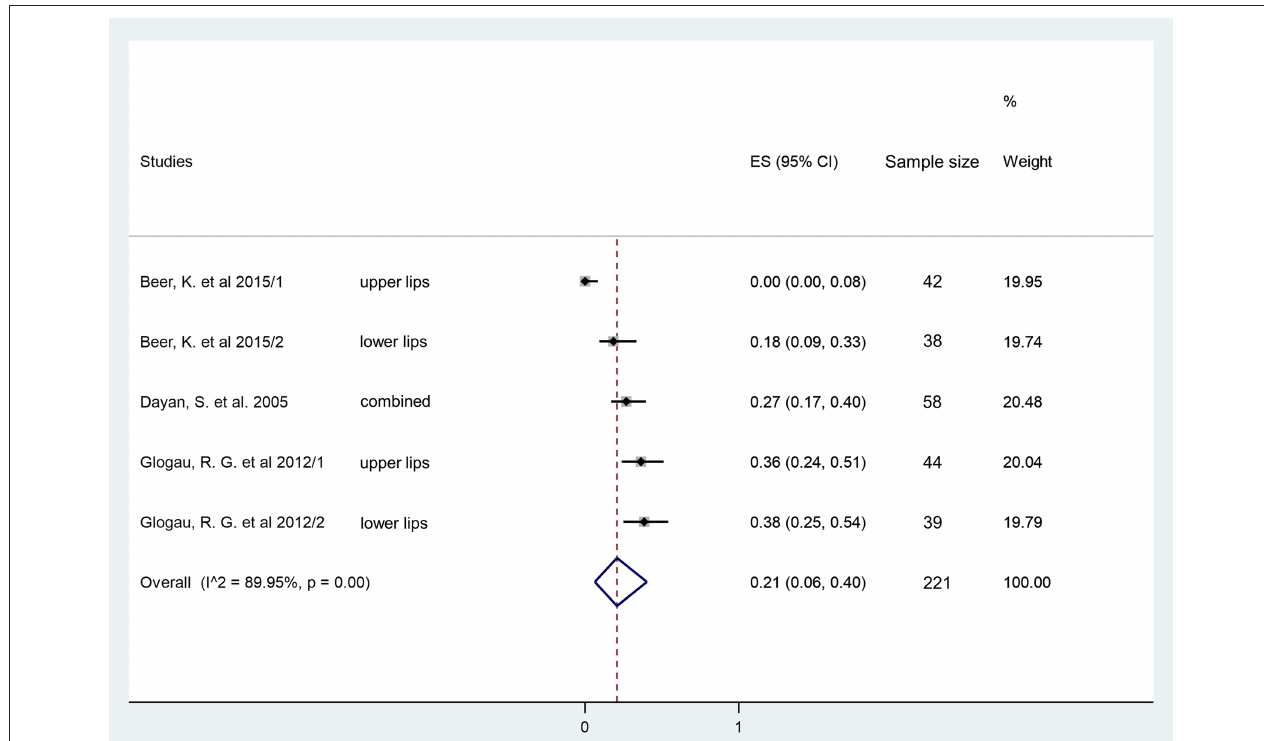
FIGURE 4 | Estimate of overall rate of responders at 2 months in the no treatment group. Overall, 21% (95% CI: 6–40%) of included participants had at least one grade improvement on a validated lip fullness scale after 2 months in the no treatment